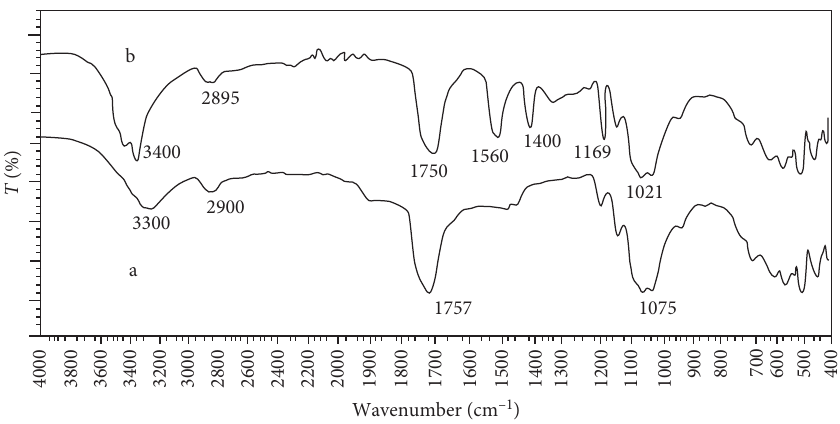
Figure 2: FT-IR spectra of (a) bare cotton fibers and (b) polyaniline-deposited cotton